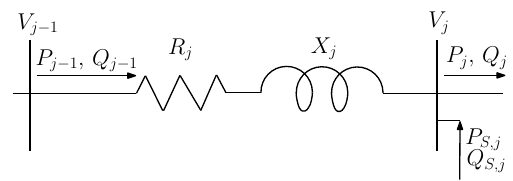
Figure 3. Electric equivalent circuit of the j -th branch of a